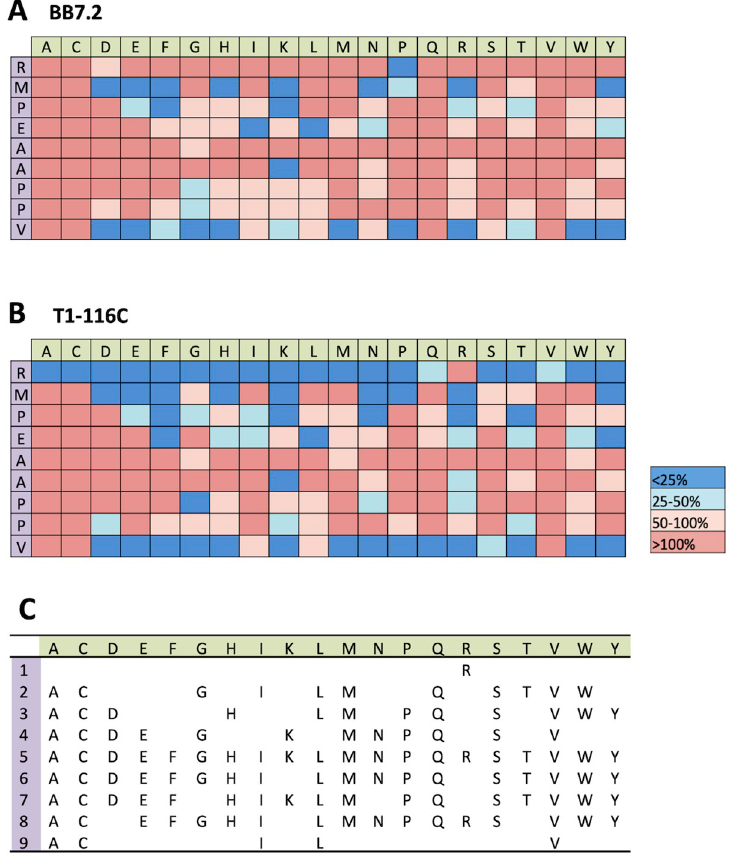
Fig 4. Comprehensive amino acid substitution identifies a complex peptide consensus. Each individual amino acid in the p53RMP nonamer was replaced one at a time with the essential amino acids, generating 172 peptides for testing. T2 cells were pulsed with each of the peptides and stained with ( A ) anti-HLA-A2 antibody (BB7.2) or ( B ) T1-116C. Antibody binding was categorized, relative to the binding observed with the wild type p53RMP peptide using the MFI values: enhanced ( > 100%), maintained (50–100%), reduced (25-50%), or severely diminished ( < 25%). The data represent averages of two independent biological replicates. ( C) Summary of the amino acid substitutions at each position within p53RMP that retain T1-116C binding ( � 50% the wild type